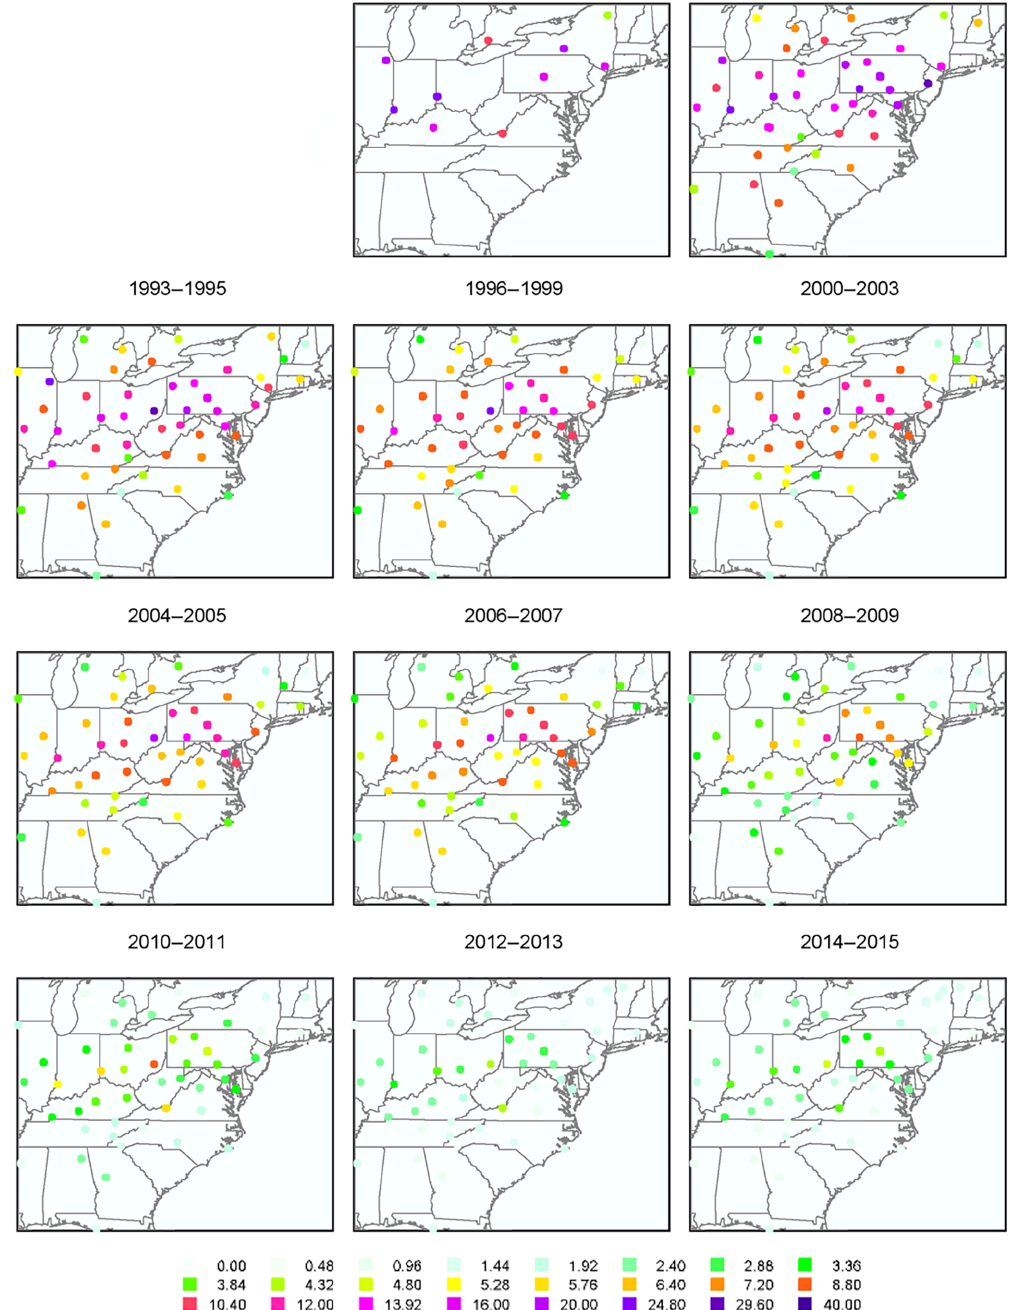
Figure 8. Annual mean surface SO 2 concentrations in µgm − 3 for different periods calculated using data from the CASTNet and CAPMoN surface monitoring networks. The area 30 to 48 ◦ N and 70 to 90 ◦ W is